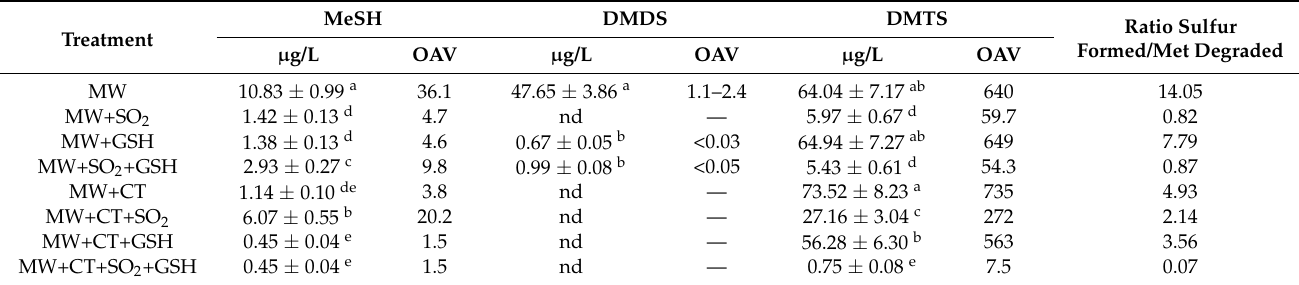
Table 2. Concentrations ( µ g/L) of methanethiol (MeSH), dimethyl disulfide (DMDS) and dimethyl trisulfide (DMTS) in model wine (MW) samples stored in the dark after light exposure.